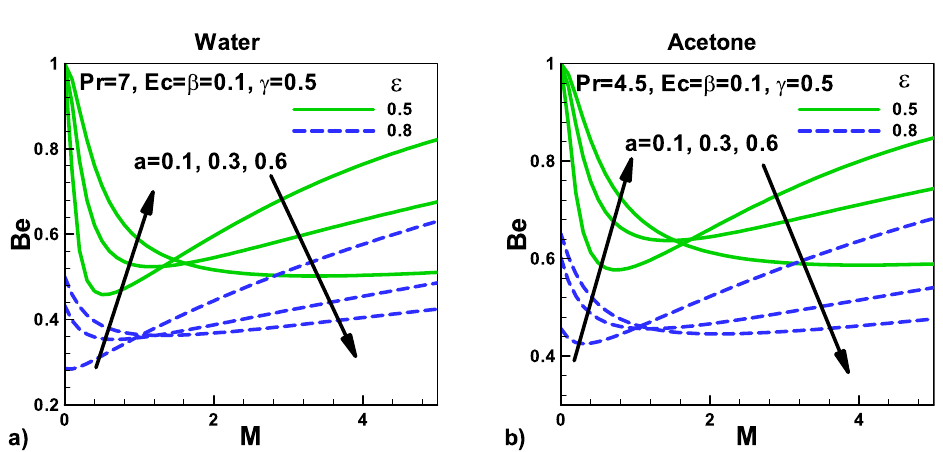
Figure 14. Variation of Bejan number with magnetic field and velocity ratio parameter at different positions for ( a ) water ( b )